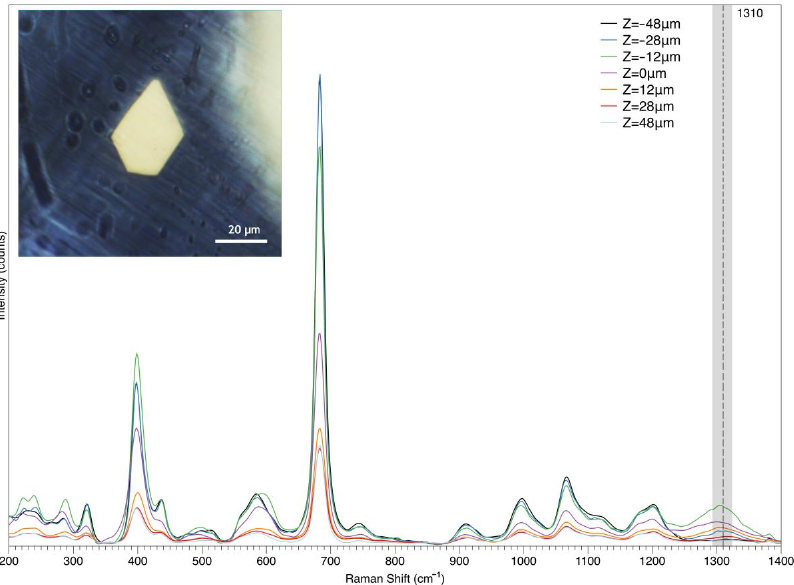
Figure 14. One hematite was selected for Raman mapping, and this figure demonstrated the strength variation in the 1310 cm − 1 peak along the z -axis, ranging from − 48 μ m to 48 μ m with fi xed x and y.